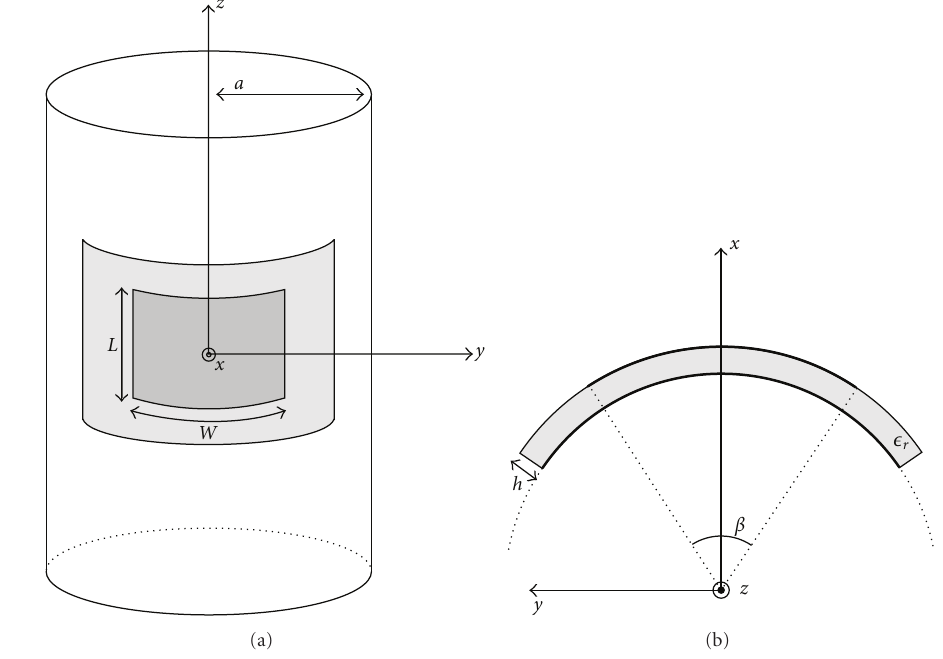
Figure 1: Geometry of the cavity: top view (a) and side view (b).